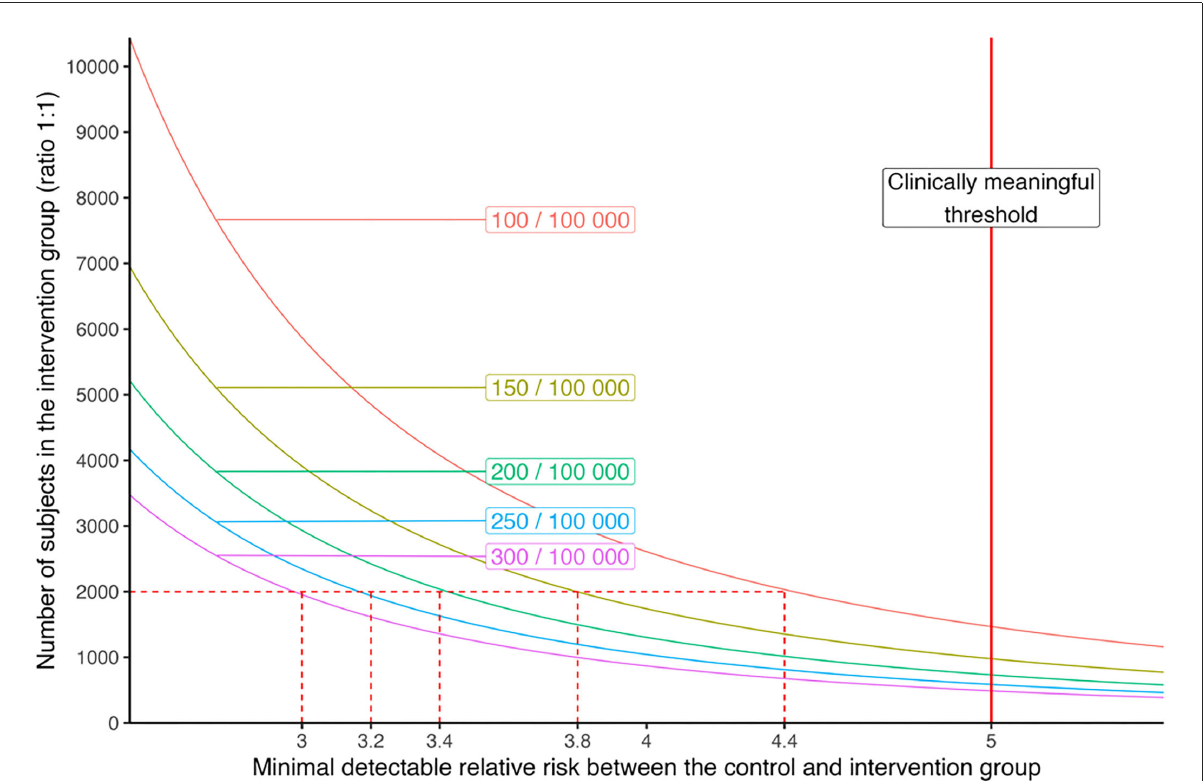
FIGURE3 Minimal detectable relative risk depending on the number of subjects in the intervention group for different levels of incidence of SARS-CoV-2 infection detected in the general population. With 2,000 subjects in each arm (intervention and control), we have a power of 80% to detect a relative risk of 3–4.4 depending on the level of SARS-CoV-2